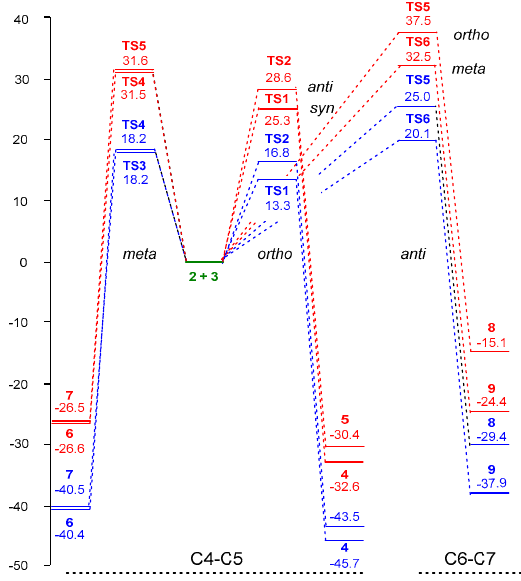
Figure 3. Enthalpy profiles, ∆ H in blue (kcal · mol − 1 ), and Gibbs free energy profiles, ∆ G in red (kcal · mol − 1 ), for the studied reaction paths of the 32CA reaction of α -santonin derivative 2 with p -bromophenyl nitrile oxide 3 , in the presence of THF at 0 °C.